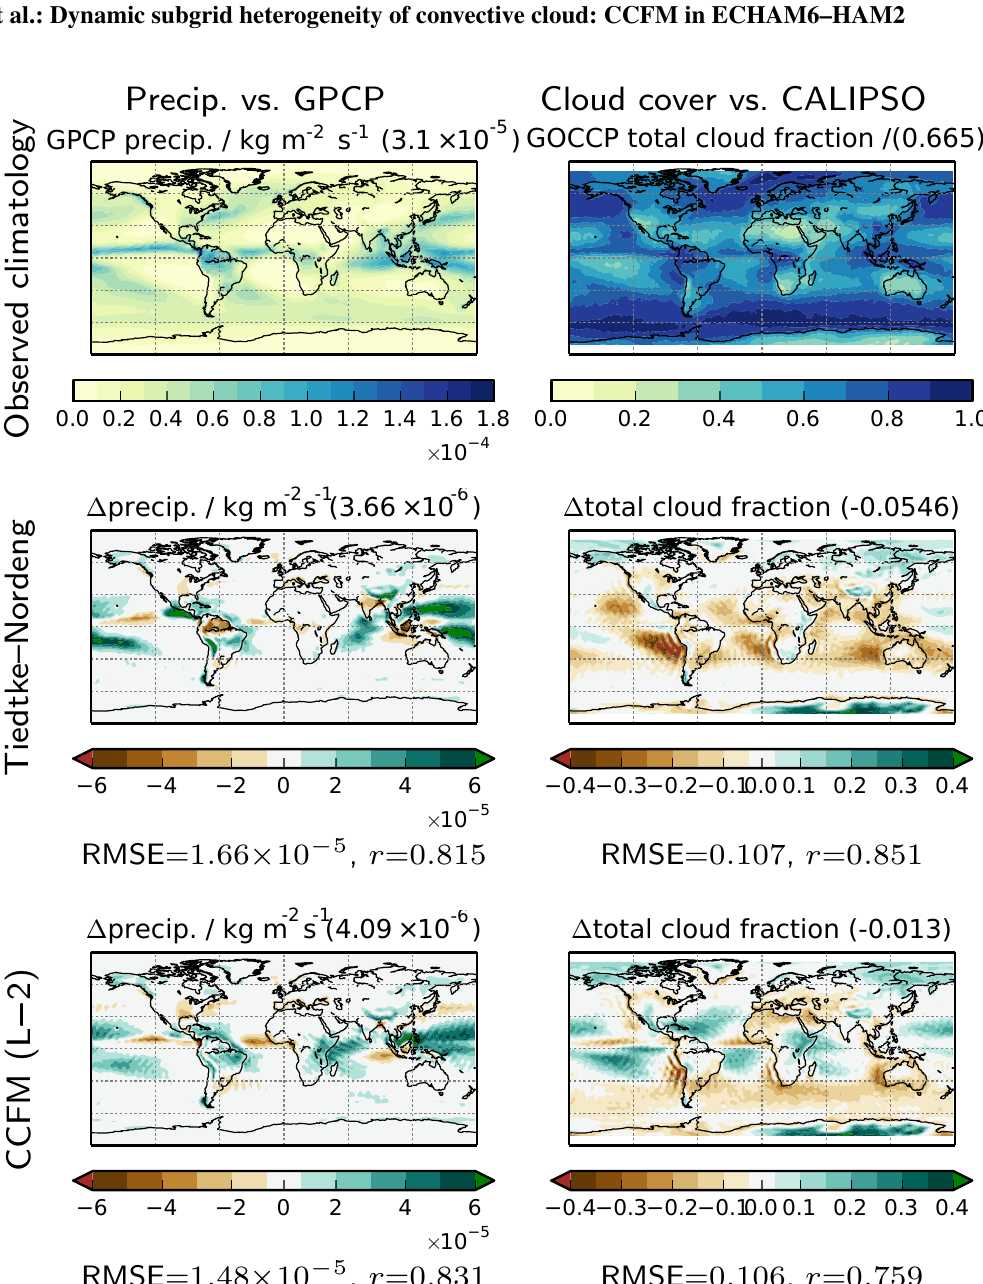
Figure 4. Difference in annual mean precipitation (left) and COSP-simulated cloud fraction (right) between 30-year AMIP-type simulations using ECHAM–HAM with Tiedtke–Nordeng and CCFM (L − 2) convection, and the Global Precipitation Climatology Project (GPCP) and CALIPSO–GOCCP